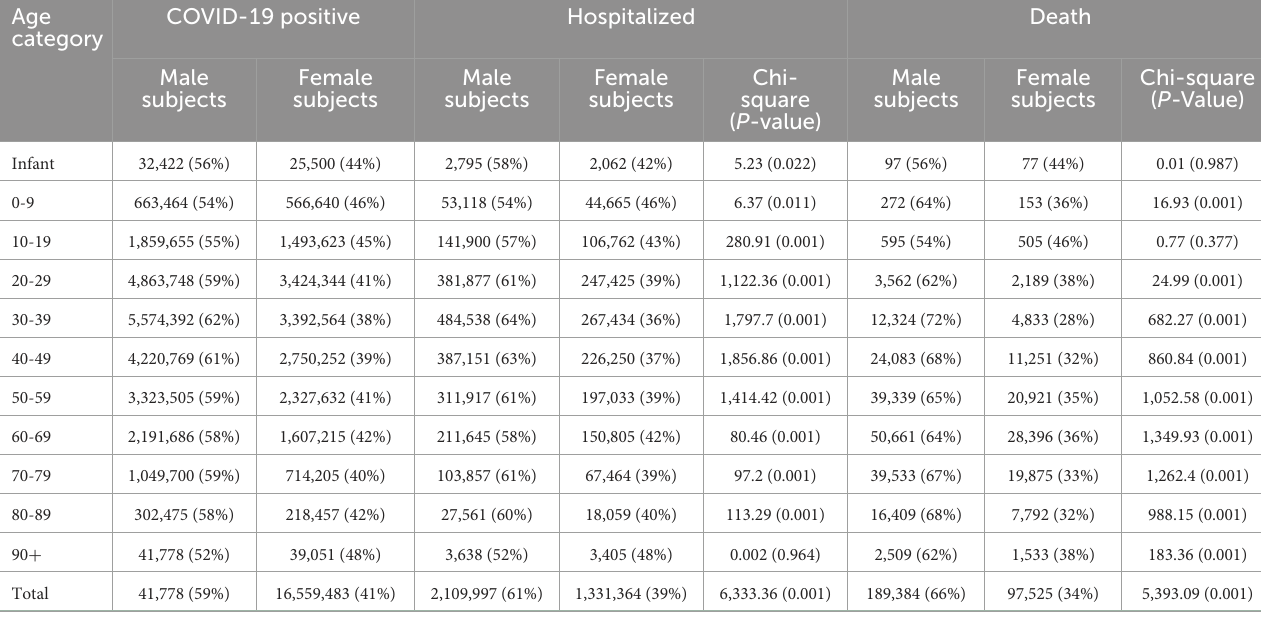
TABLE 2 Characteristics of patients with COVID-19 according to gender.